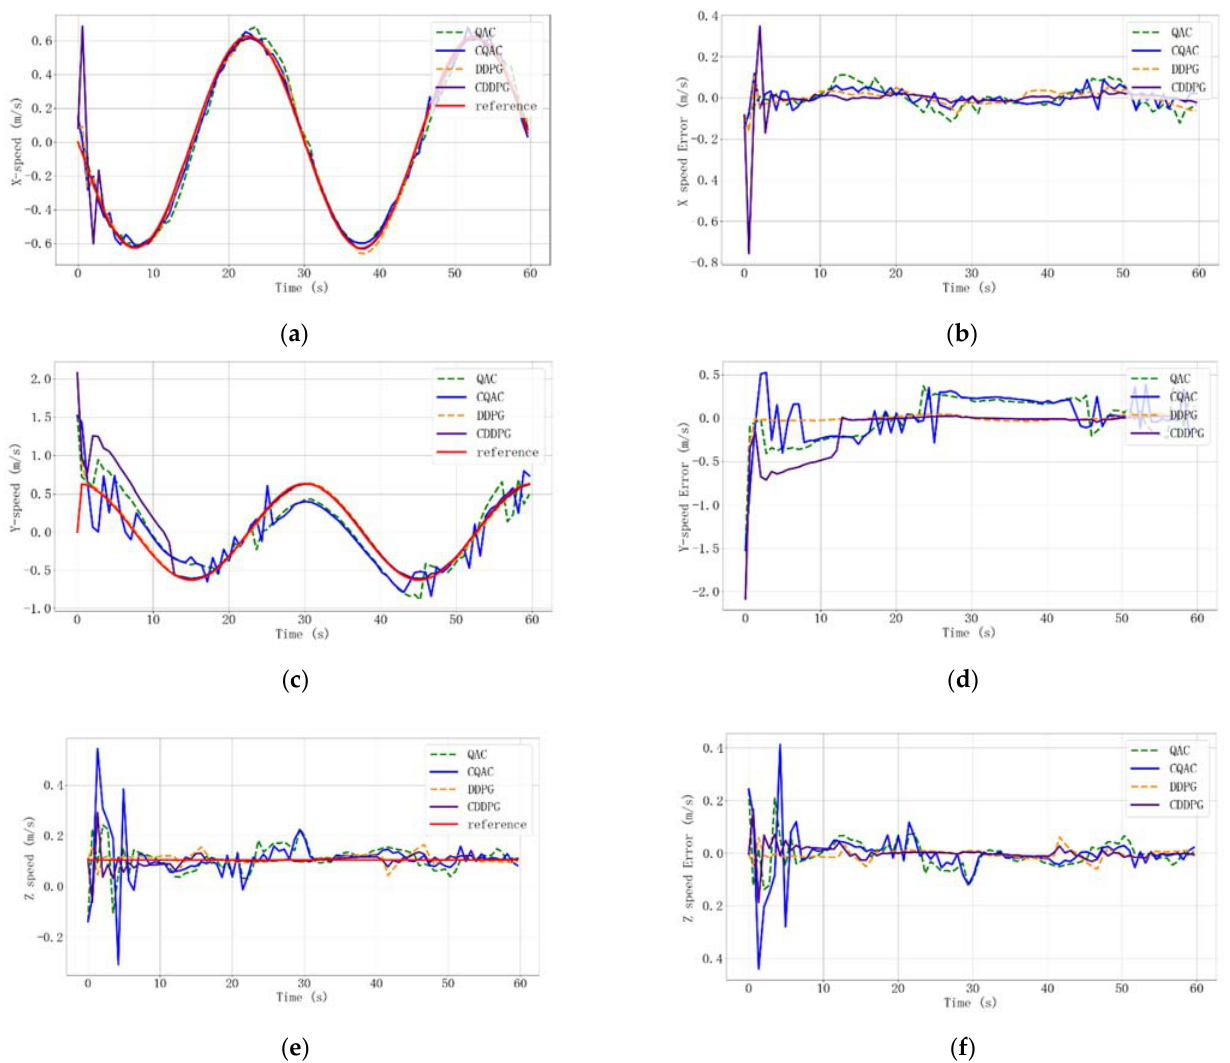
Figure 15. ( a ) X ‐ direction tracking speed of four algorithms; ( b ) X ‐ direction velocity error of four Figure 15. ( a ) X-direction tracking speed of four algorithms; ( b ) X-direction velocity error of four algo- algorithms; ( c ) Y ‐ direction tracking speed of four algorithms; ( d ) Y ‐ direction velocity error of four rithms; ( c ) Y-direction tracking speed of four algorithms; ( d ) Y-direction velocity error of four algorithms; algorithms; ( e ) Z ‐ direction tracking speed of four algorithms; ( f ) Z ‐ direction velocity error of four ( e ) Z-direction tracking speed of four algorithms; ( f ) Z-direction velocity error of four algorithms.